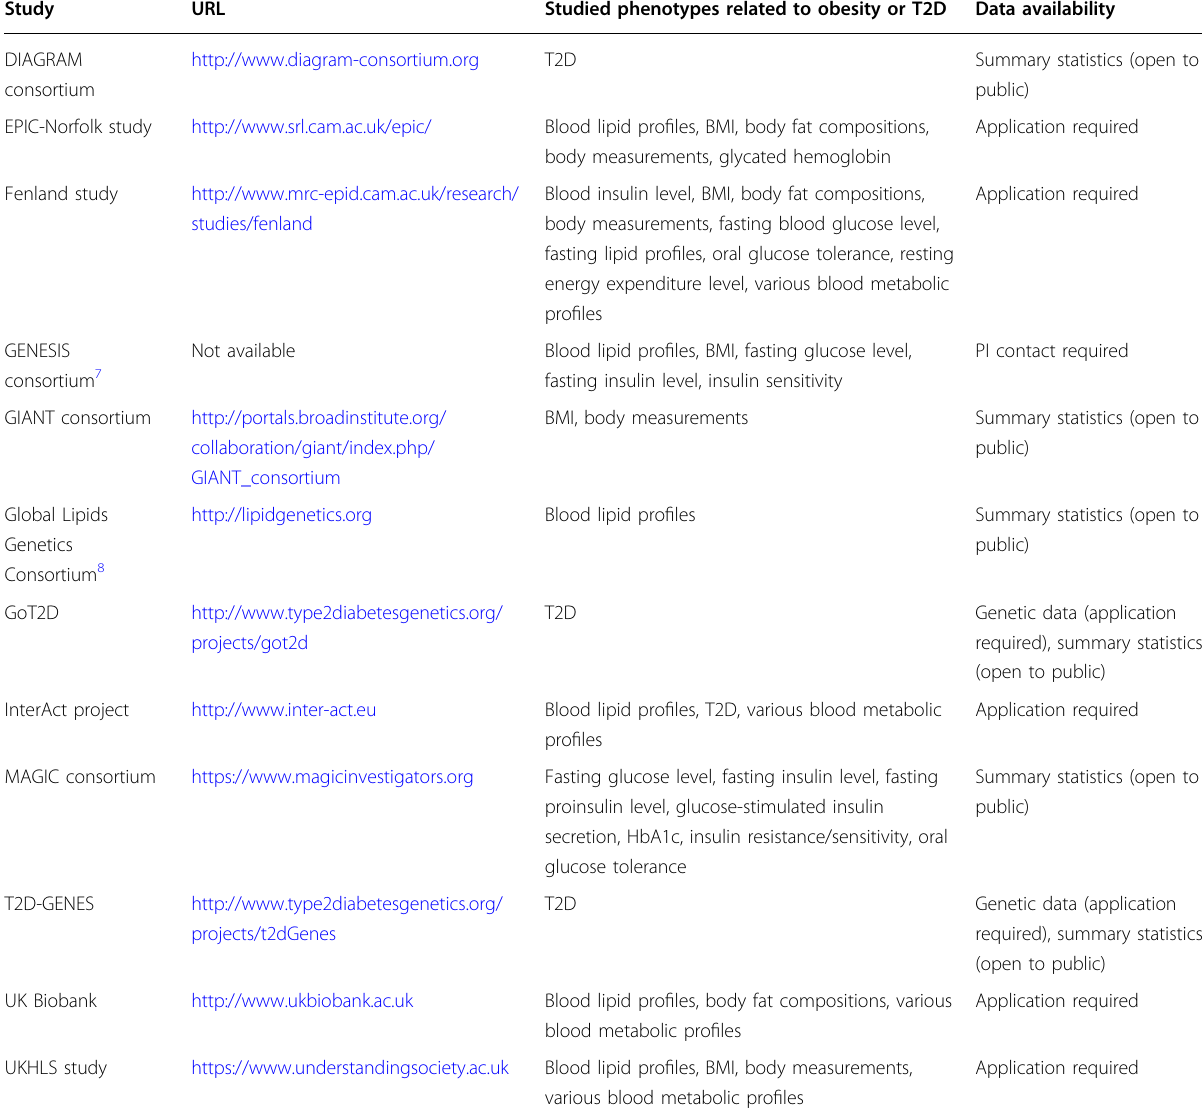
Table 1 Selected popular GWAS related to obesity or